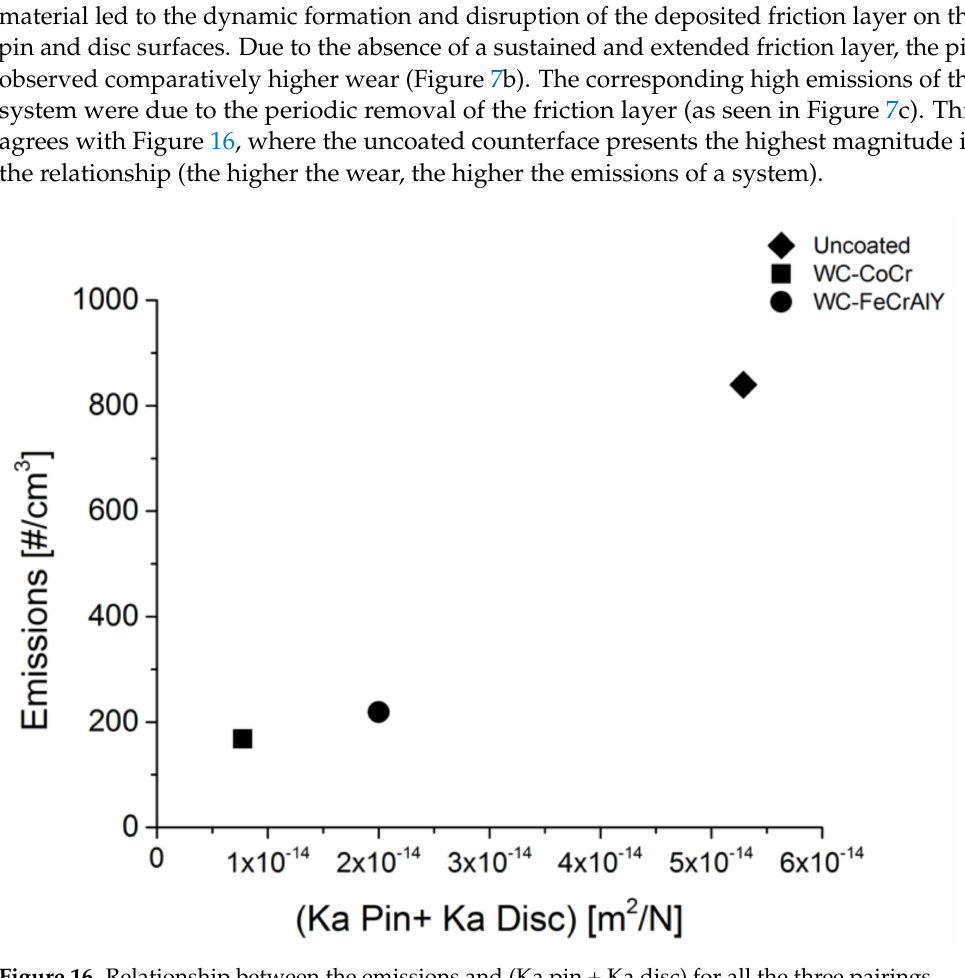
Figure 16. Relationship between the emissions and (Ka pin + Ka disc) for all the three pairings. Along with the presence of the friction layer, the TEM analysis with the uncoated disc pairing also recorded the presence of SiC and graphite, which could be due to the brittle detachment from the pin surface. As seen from Figure 9, SiC and graphite do not take part in the formation of the friction layer. Hence, the TEM analysis did not observe any other constituents that were attached to the SiC and graphite particles. Lastly, the hard